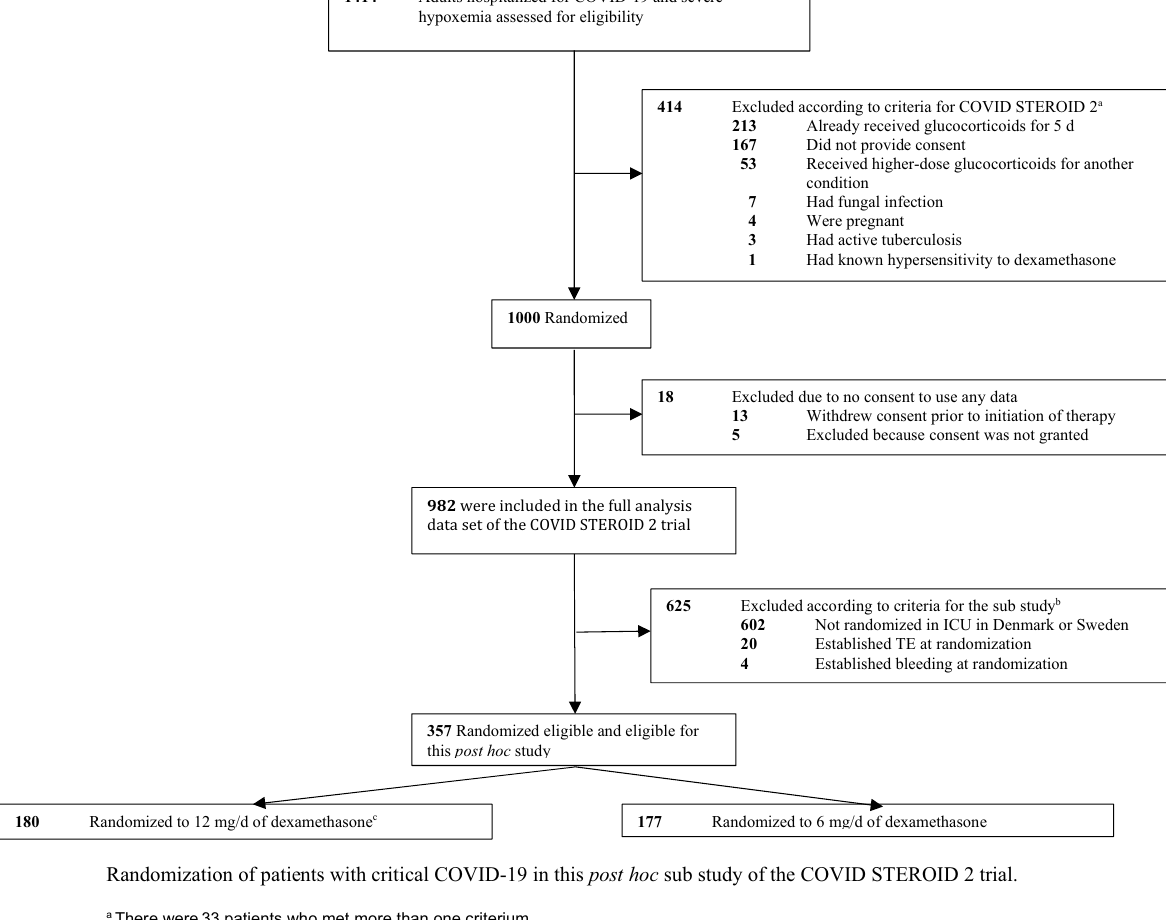
Fig. 1 Patients with critical COVID‑19 in the post hoc, study of the COVID STEROID 2